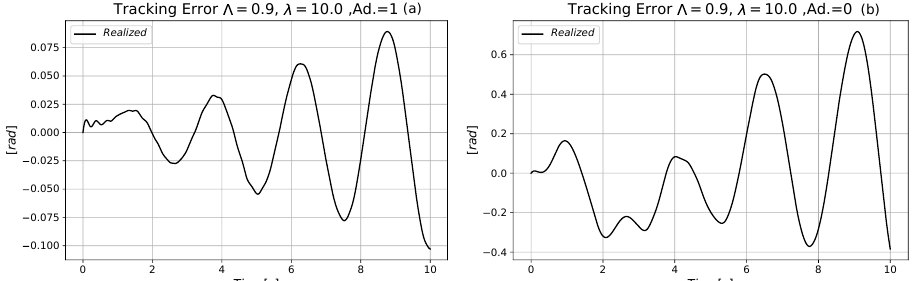
Figure 20. The trajectory tracking error. ( a ): Adaptive. ( b ):